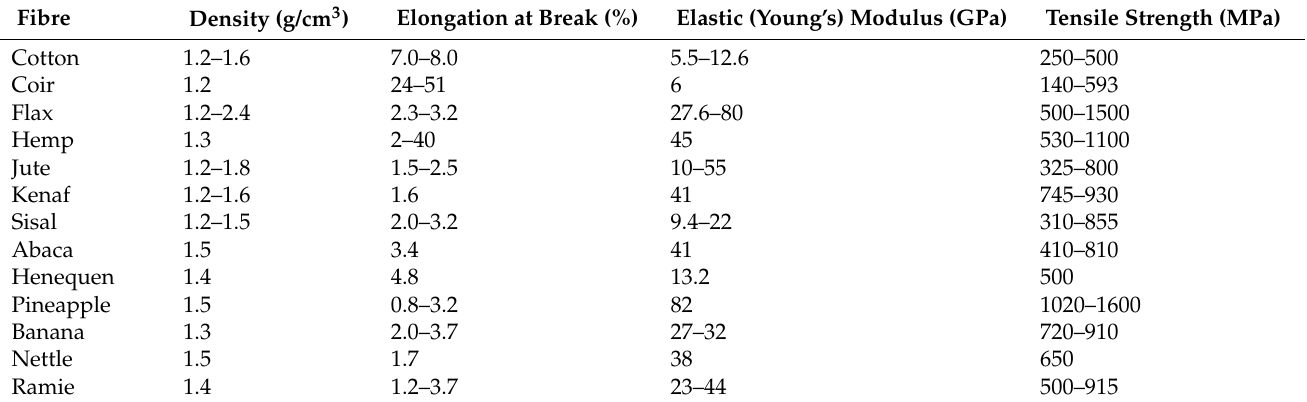
Table 2. Mechanical properties of several natural fibres (data reproduced from